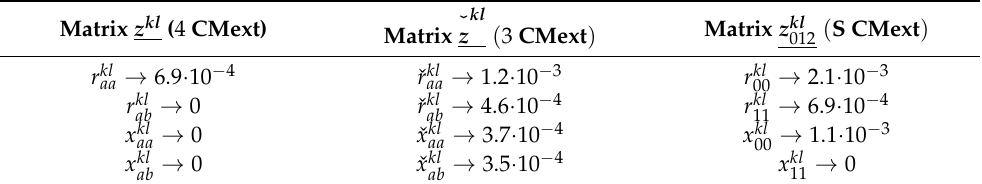
Table 5. The slope of terms of three matrices with respect to temperature ( Ω /km/ ◦